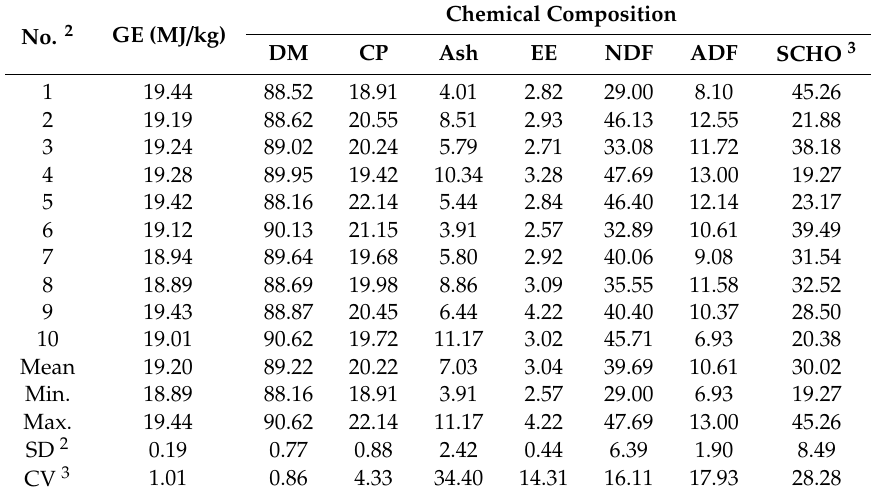
Table 5. Analyzed chemical composition of wheat bran (%, DM basis) 1 .